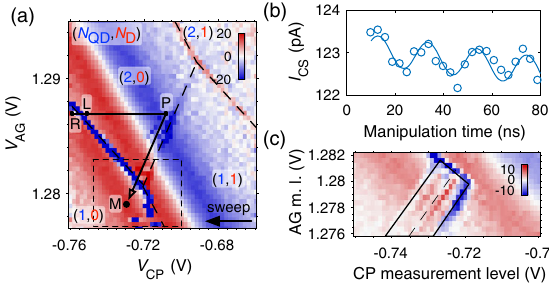
FIG. 4. (a) Anticrossing of donor 2 (no pulse applied) and pulse sequence used to demonstrate the high-fidelity direct ELR. Color =dV scale: dI (a.u.). (b) This QD-D anti-crossing can produce CS CP low-visibility hyperfine-driven coherent rotations as in Ref. [21]. The visibility is limited by the low bandwidth of the pulse compared with the t C and effective magnetic field difference Δ B z . (c) An averaged measurement technique, which is used to image the edges of the enhancement region by varying the location of the measurement point. FIG. 3. (a) – (d) Relaxation or excitation time versus the detun- ing ϵ for the different readouts on donor 1. The data are taken along detuning cuts schematized in panel (a). Non-negligible excitation times are only observed in the PSBR case. For the ELR, excitation is strongly suppressed by the large δ > 100 μ eV energy cost (see Fig. 2). The fit in panel (b) corresponds to a simple relaxation model where the metastable relaxation rate Γ ¼ Γ β 2 and β ≈ t = ϵ from the interdot tunnel ð 2 ; 1 Þ ← ð 1 ; 1 Þ C MS coupling t C (full gap). Here, ϵ is calibrated with the measured lever arm parallel to the QD ↔ lead transition ( 32 . 4 μ eV = mV), and the QD loading rate Γ ð 2 ; 1 Þ ← ð 1 ; 1 Þ ¼ 2 . 56 MHz is measured independently. The fit yields t C ¼ 0 . 54 μ eV. This value is consistent with independent measurements through diabatic or adiabatic passage